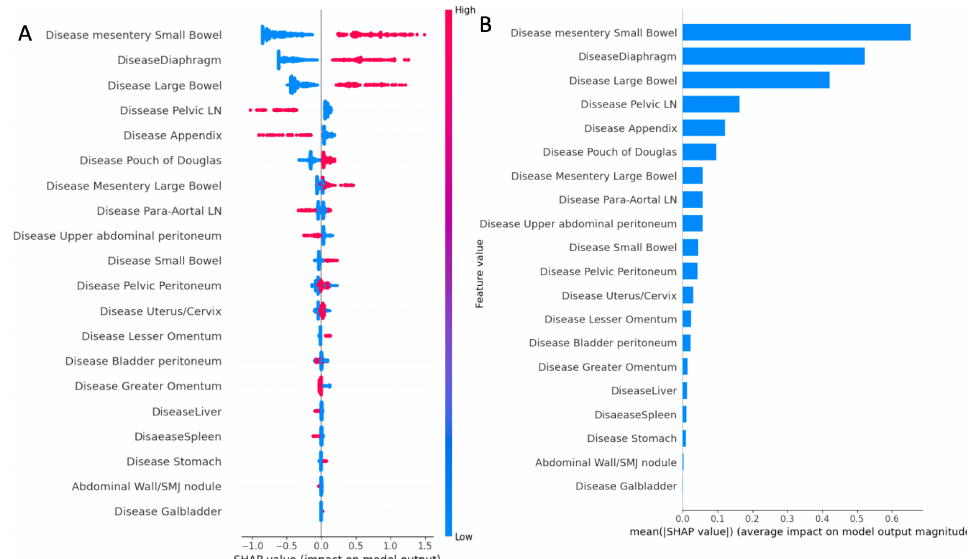
Figure 1. ( A ) Summary plot showing a set of beeswarm plots of feature distribution for global explainability of CC0 prediction based on the anatomic fingerprints of EOC distribution. Dots correspond to the individual EOC patients. ( B ) Feature importance bar plot description of SHAP values for EOC anatomic fingerprints.